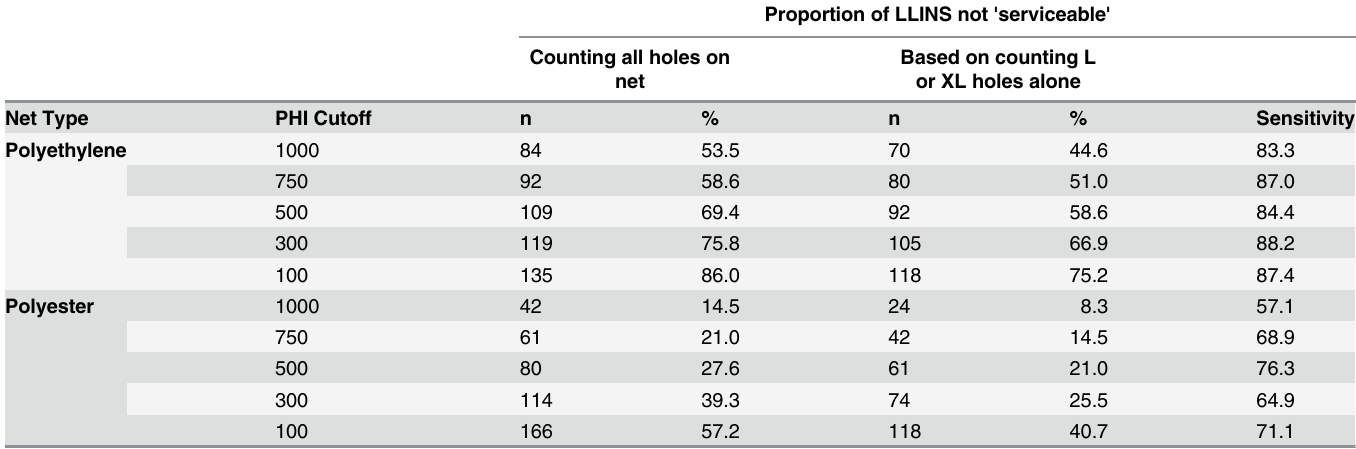
Table 6. Proportion of nets determined to be unusable by 1) counting all holes on the net, 2) counting only number of extra-large (XL) and large (L) holes on the net for different PHI cutoffs by net